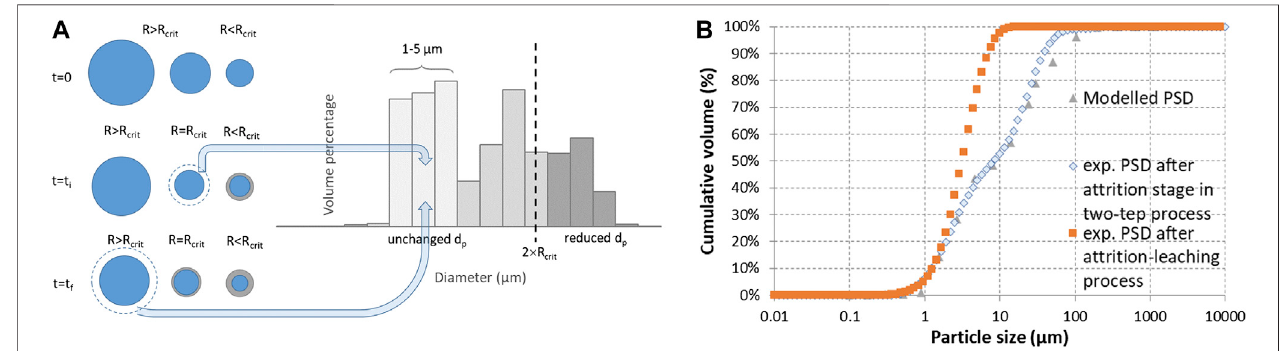
FIGURE 14 | Modelled PSD issued from the mixed model: (A) schematic description and (B) comparison with measured cumulative size distributions of slag particles after 24 h of attrition grinding using stainless steel beads (in two-step and attrition-leaching processes) (conditions of Figure 13 ).